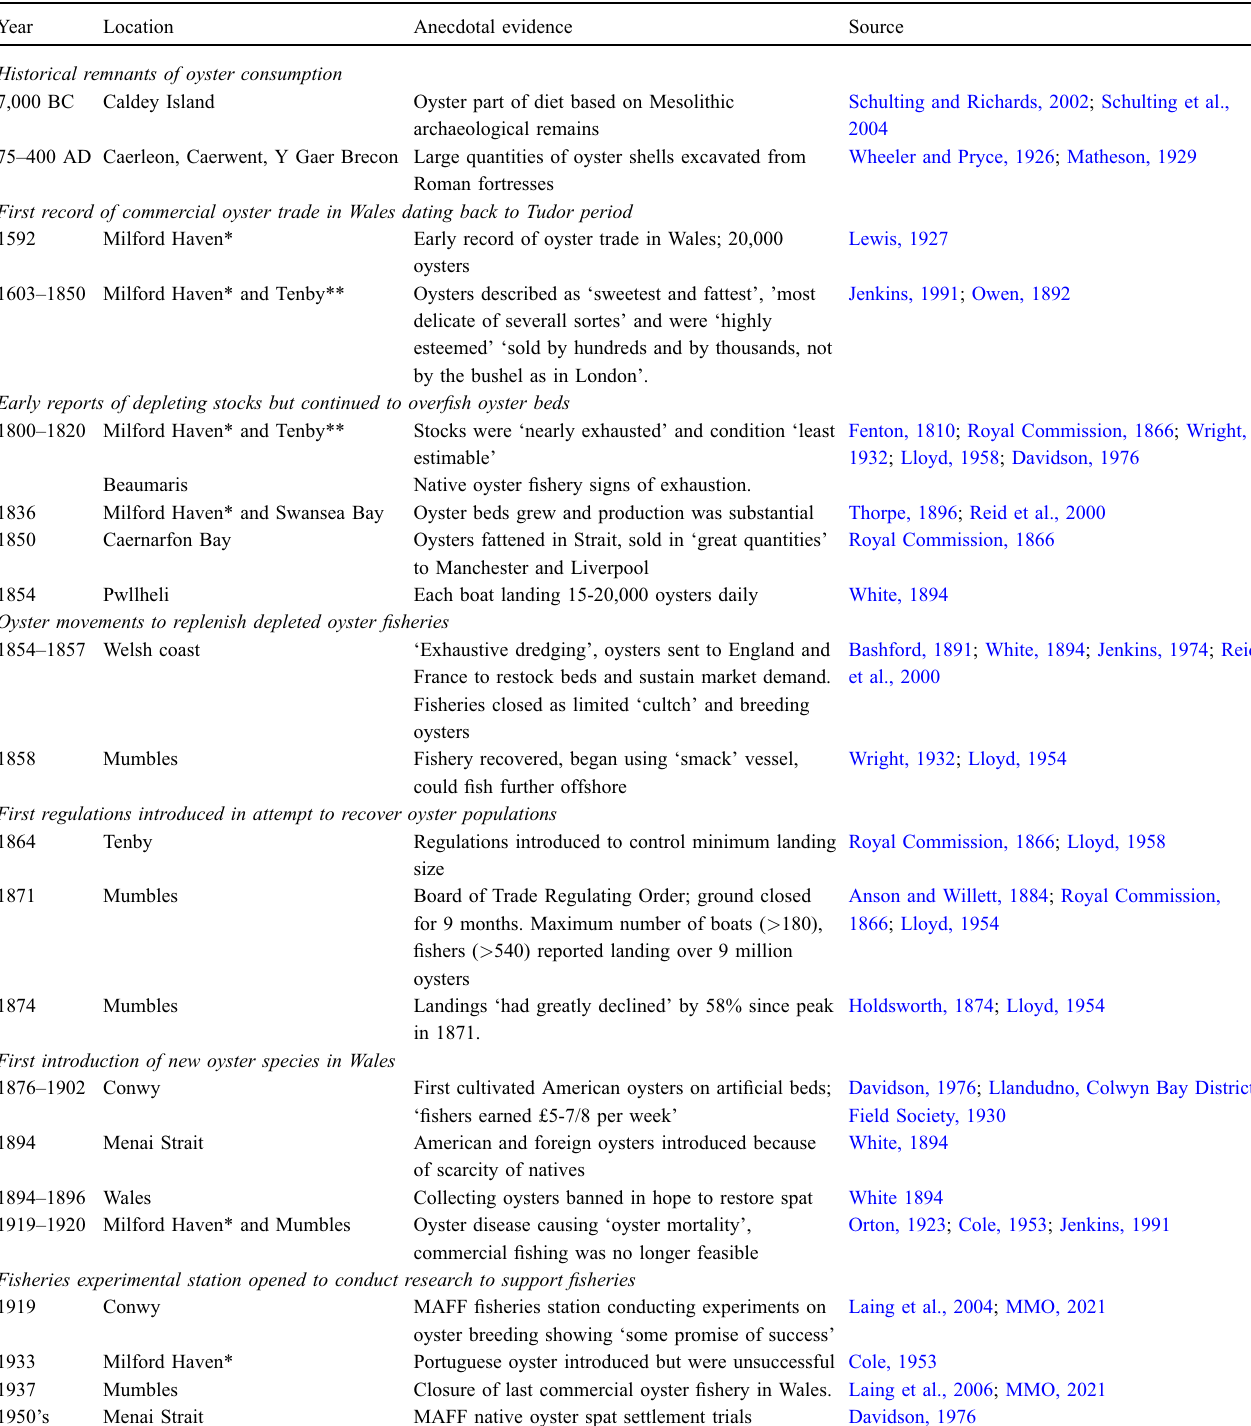
Table 1. Historical timeline of oyster fi shery in Wales from 7000 BC to